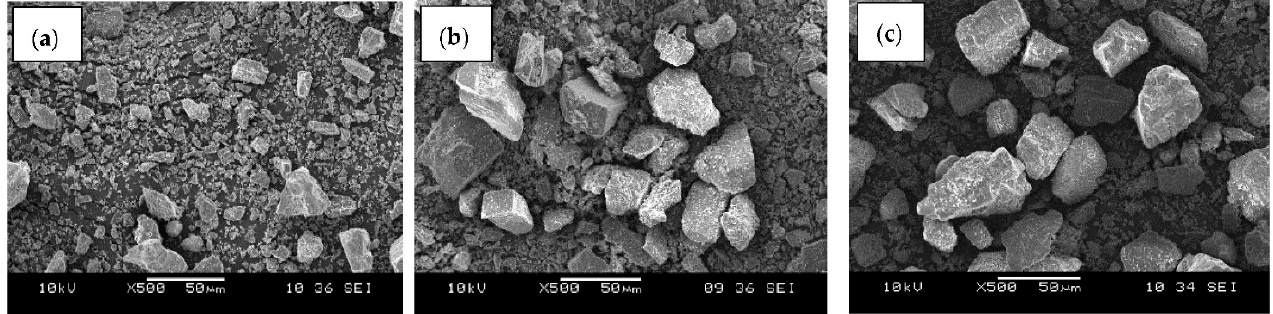
Figure 2. SEM images of dolomite that has been tip-ultrasonicated for ( a ) 2 h, ( b ) 3 h, and ( c ) 5 h at ×500 magnification.